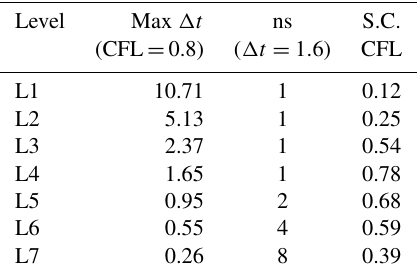
Table 1. CFL values used after introducing subcycling (S.C. CFL) for each of the seven levels. The second column shows the max- imum (cid:49)t per level using CFL = 0.8 and the third column shows the number of subcycles (ns) required in each level when using (cid:49)t = 1 . 6.